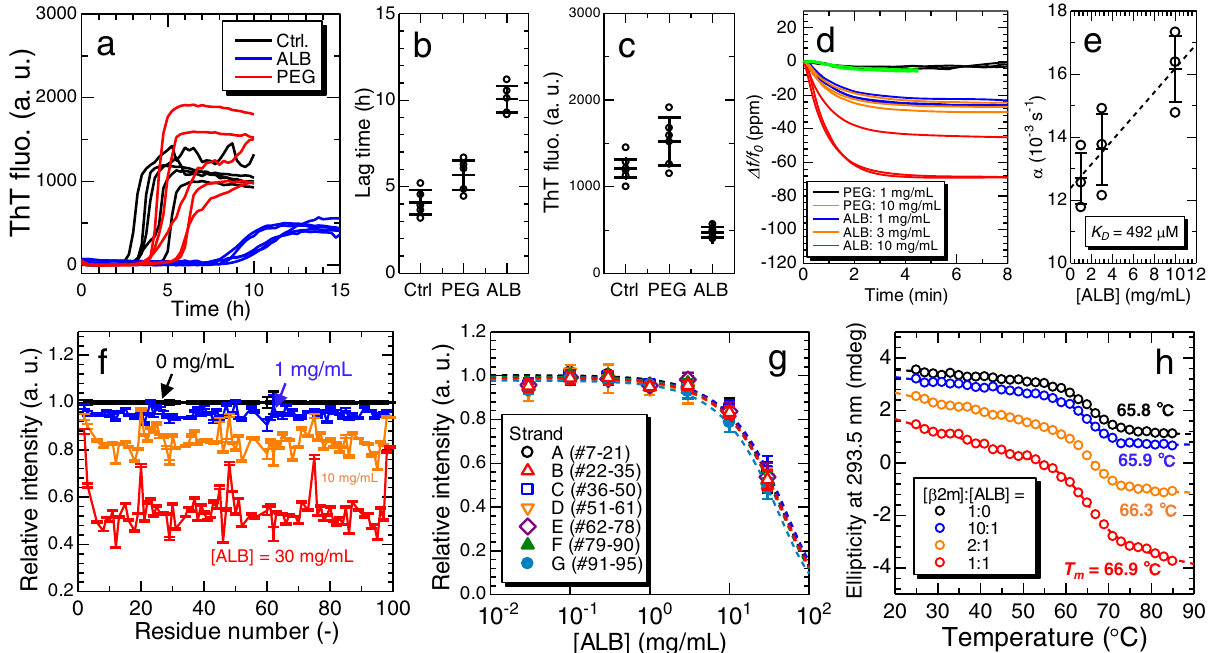
Fig. 5 | Analysis on interaction between β 2m monomer and serum albumin. a – c The effects of serum albumin (ALB) and polyethylene glycol (PEG) on β 2m amyloid fi bril formation. a ThT fl uorescence kinetics in the presence of 5mg/mL serumalbumin(ALB)orpolyethyleneglycol(PEG)( n =5),( b )theirlagtimes,and( c ) ThT fl uorescenceintensities.Centersforerrorbarsanderrorbarsdenotethemean and standard deviation among independent sample solutions ( n =5), respectively. d , e Interactions between β 2m monomer and serum albumin monitored by QCM experiments ( n =3): ( d ) Relative frequency change and ( e ) calculation of the dis- sociationconstant, K D , between β 2mmonomer andserum albumin. The error bars